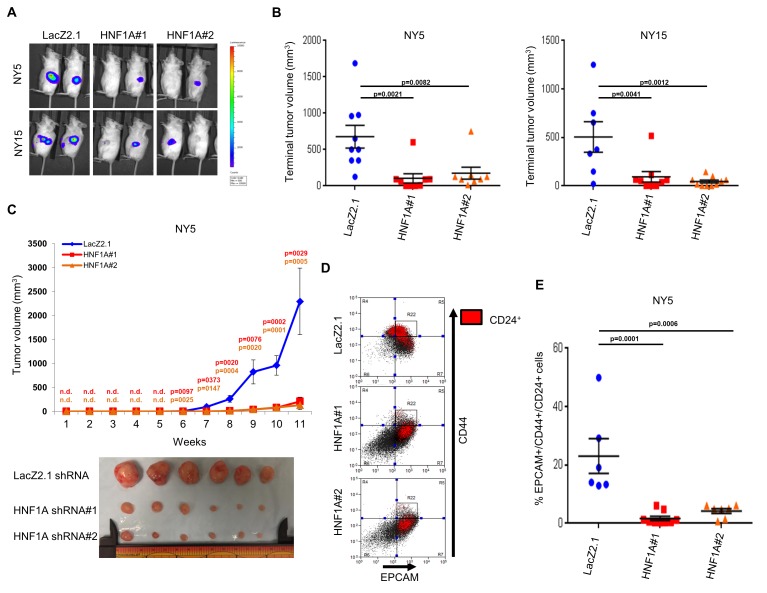
Knockdown of HNF1A impairs tumor growth and depletes CSCs in vivo.(A, B) 10,000 firefly luciferase-labeled NY5 and NY15 cells expressing control or HNF1A shRNAs were implanted orthotopically into the pancreata of NOD/SCID mice and monitored by IVIS imaging for 6 weeks (10 mice per group). Representative luminescence image of tumors prior to sacrifice is shown (A). Final tumor volumes determined during necropsy are quantitated in (B). Statistical difference was determined by one-way ANOVA with Dunnett’s multiple comparisons test. (C) 103 control or HNF1A-depleted NY5 cells were implanted subcutaneously in NOD/SCID mice (10 mice per shRNA/bilateral injections) for 11 weeks. Tumors were measured by caliper to determine tumor growth (C, upper panel). Statistical difference was determined by one-way ANOVA with Dunnett’s multiple comparisons test. Red and orange p values indicate LacZ2.1 vs. HNF1A#1 or #2, respectively. ‘n.d.’ indicates that tumors were not detected. Representative tumors excised at sacrifice are shown (C, lower panel). (D, E) NY5 tumors from (A) were dissociated and stained for EPCAM, CD44, and CD24. Representative flow cytometry plots for recovered tumor cells are shown in (D), where the R22 gate denotes EPCAMHigh/CD44High cells, and CD24 +cells are donated in red. Quantitation of EPCAM+/CD44+/CD24 +cells is shown in (E), n = 6 tumors each for shRNA. Statistical difference was determined by one-way ANOVA with Dunnett’s multiple comparisons test. Related data can be found in Figure 5—figure supplement 1.10.7554/eLife.33947.021Figure 5—source data 1.Quantitation of orthotopic and subcutaneous xenograft tumor volumes, and quantitation of PCSCs following HNF1A knockdown.10.7554/eLife.33947.022Figure 5—source data 2.Quantitation of subcutaneous xenograft tumor volumes following HNF1A knockdown.